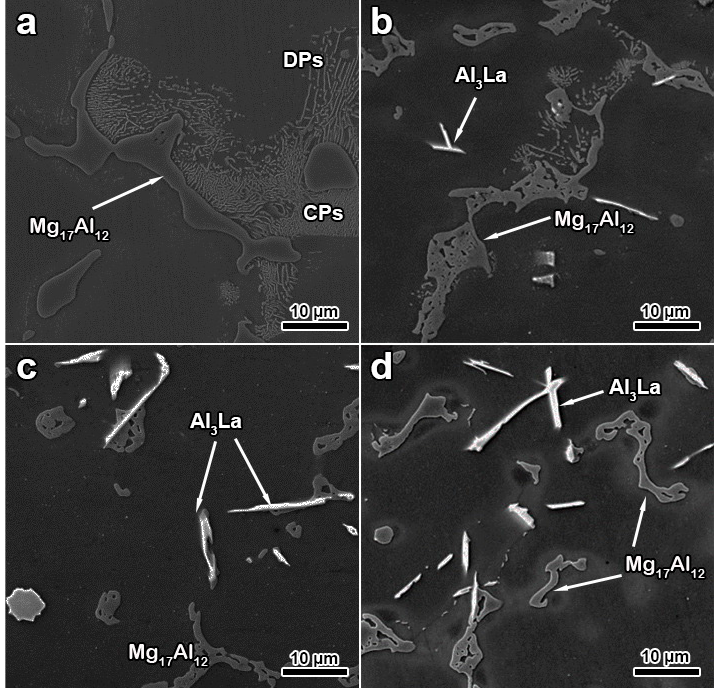
Figure 3. The SEM micrographs of ( a ) AZ91, ( b ) AZ91–0.5La, ( c ) AZ91–1.0La and ( d )